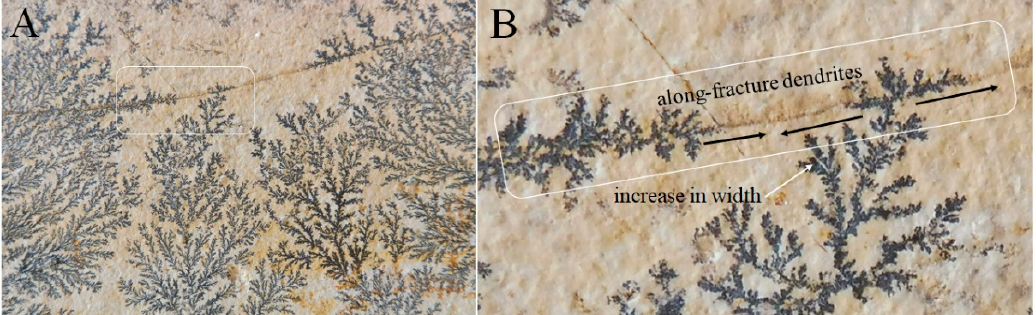
Figure 17. ( A ) Dendritic morphologies in a slab of Solnhofen lithographic limestone created by the action of oxides of iron and manganese. Image width of slab is 8 cm. The white rectangle shows the area detailed in ( B ). ( B ) Enhanced growth along fracture lines in the limestone and width increase of dendrites are apparent.